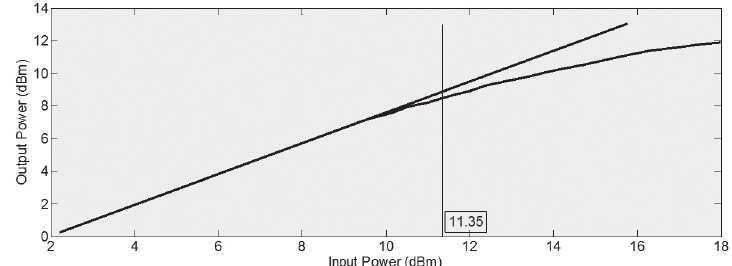
Figure 6 - Power handling performance of the switch.